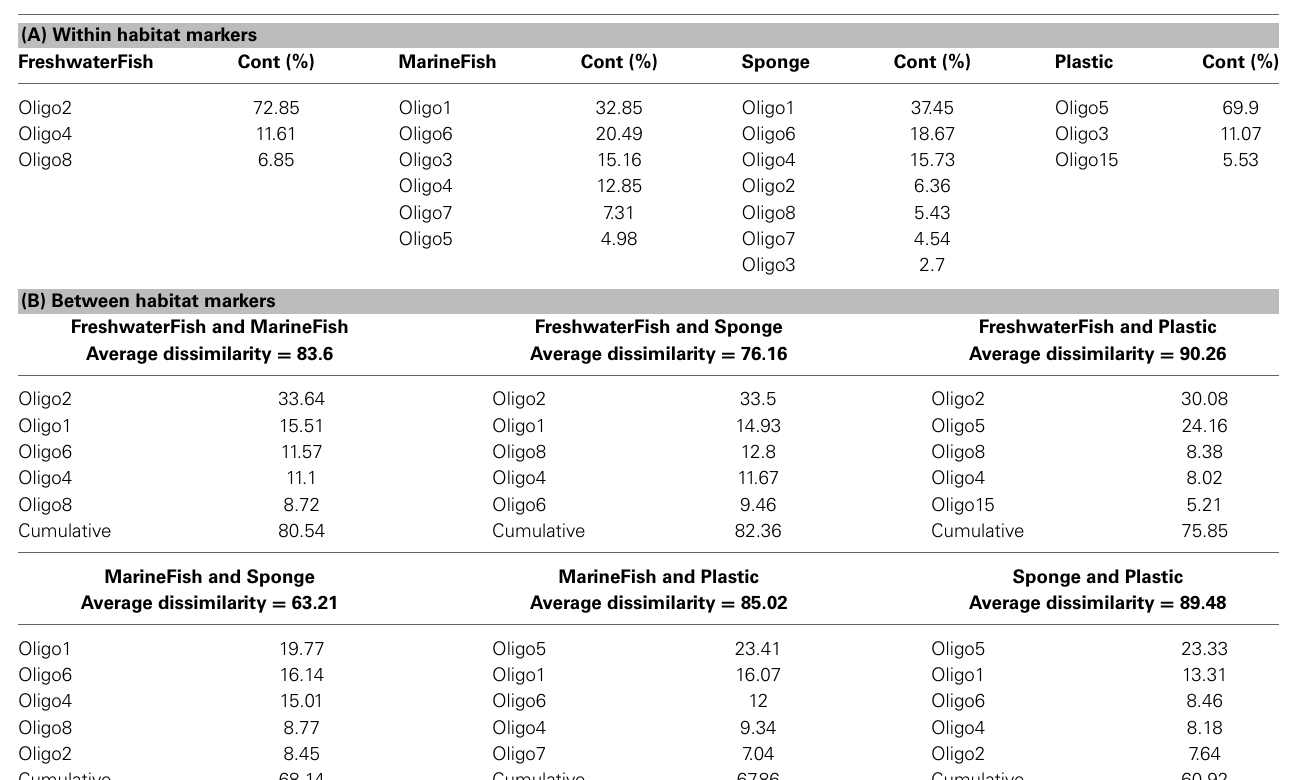
Table 4 | (A,B) SIMPER analysis output for the “All substrate” analysis